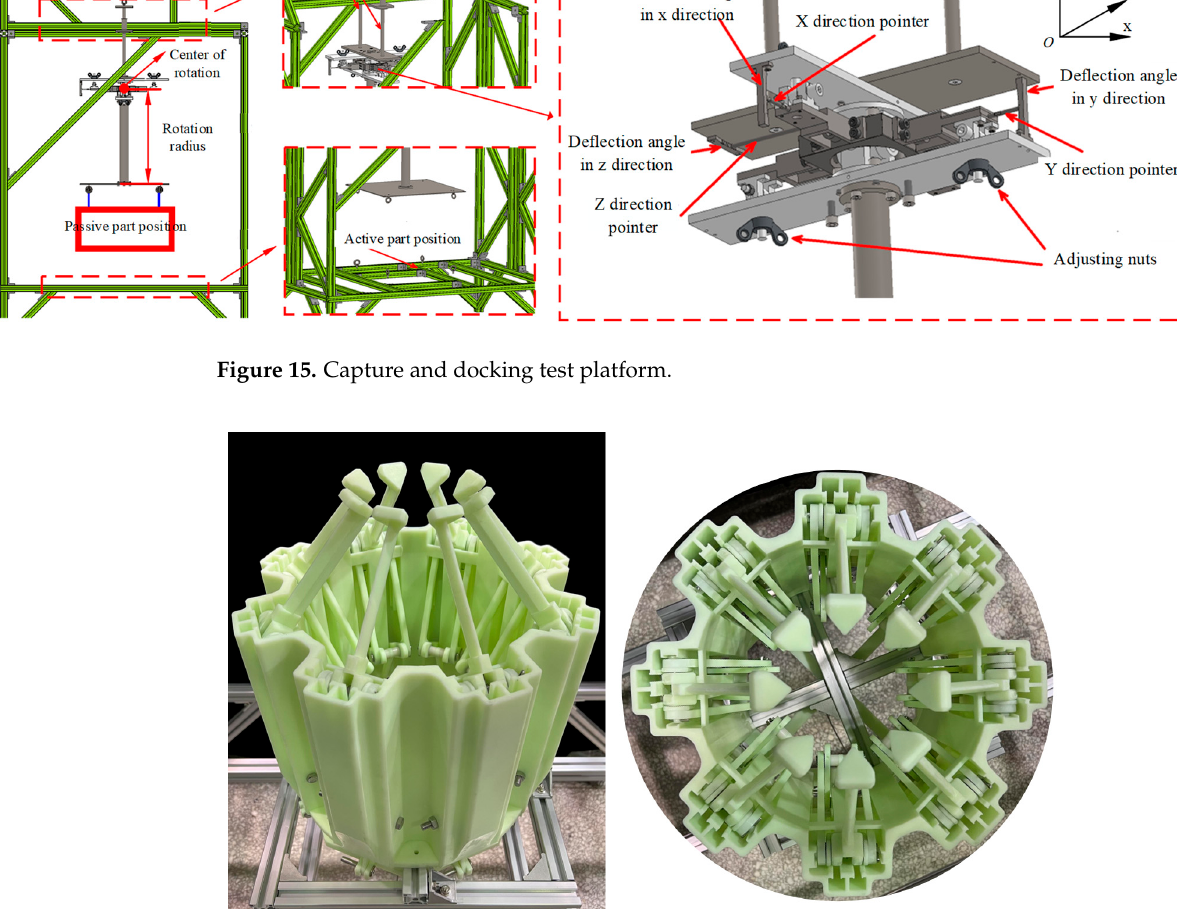
Figure 15. Capture and docking test platform.